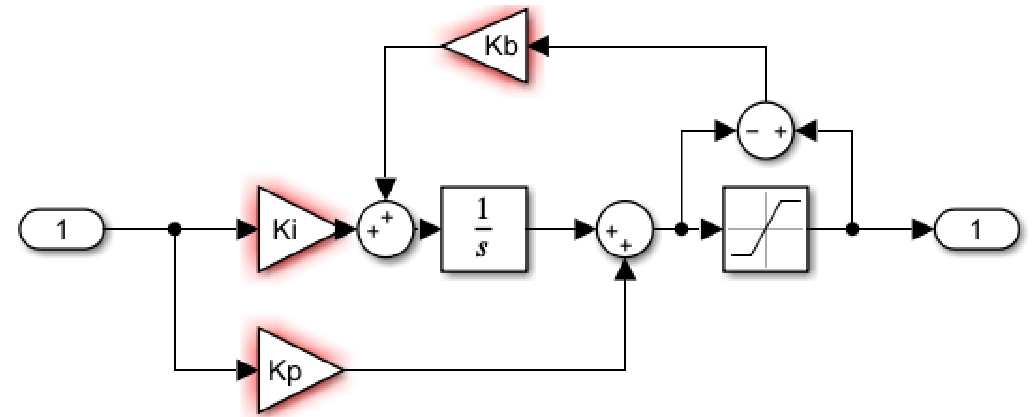
Fig. 6: Integral anti-windup employed in the weight adjustment implementation, proposed by [33]. For this implementation, the feedback gain K b is equal to the integral weight adjustment gain K i .